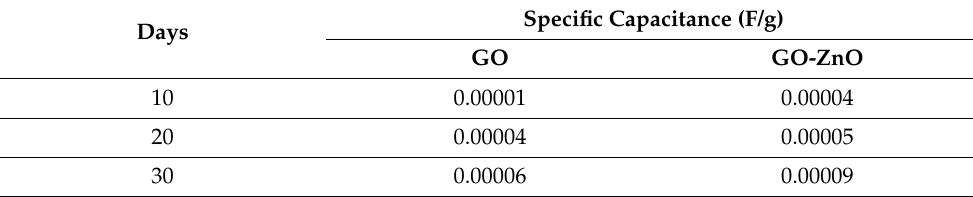
Figure 7. CV study of the GO and GO-ZnO. Table 2. C p values of GO and GO-ZnO anode CV